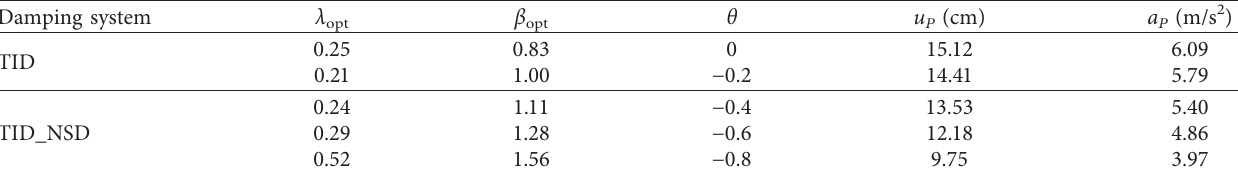
Table 2: The mean of maximum displacement and maximum absolute acceleration of the primary system subjected to the 20 ground